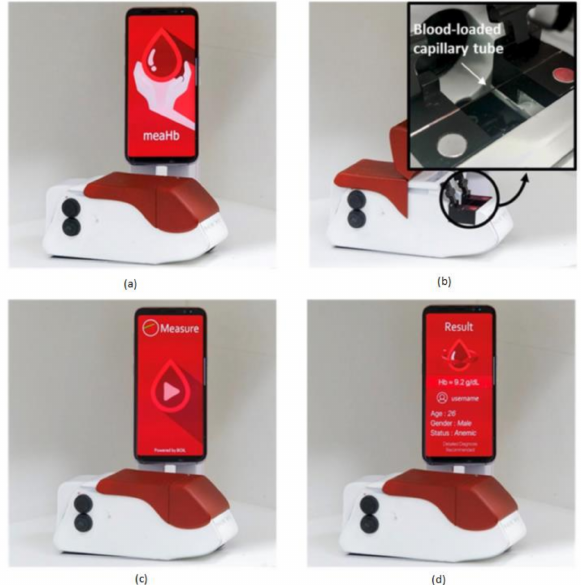
Figure 14. ( a ) Photo Thermal Angular Scattering technology (m-PTAS) sensor. ( b ) Blood sample capillary tube loaded into m-PTAS module. ( c , d ) Smartphone application “meaHb” displays the computed hemoglobin